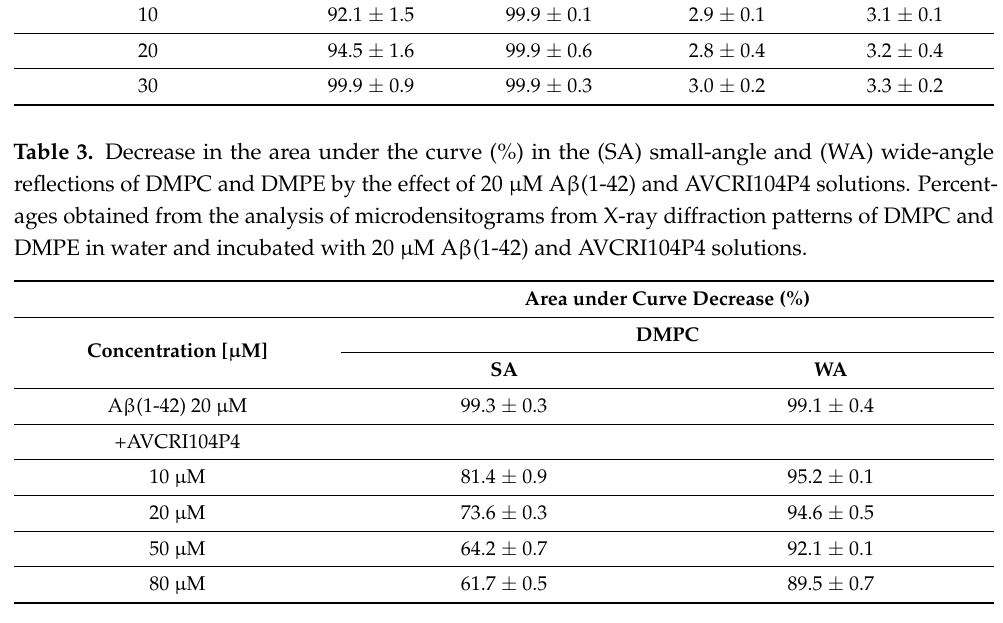
Table 3. Decrease in the area under the curve (%) in the (SA) small-angle and (WA) wide-angle reflections of DMPC and DMPE by the effect of 20 μ M A β (1-42) and AVCRI104P4 solutions. Percentages obtained from the analysis of microdensitograms from X-ray diffraction patterns of DMPC and DMPE in water and incubated with 20 μ M A β (1-42) and AVCRI104P4 solutions.